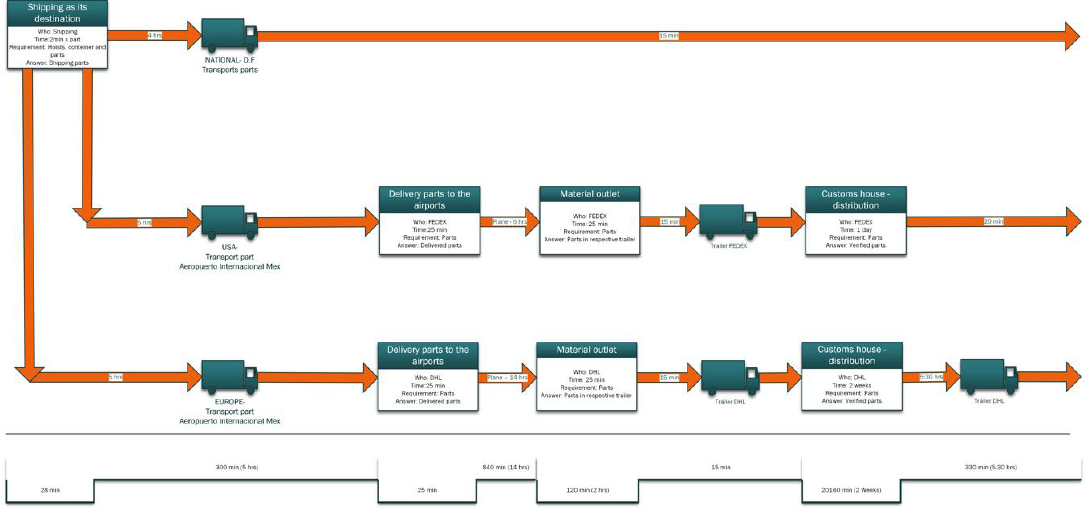
Figure 6. The fourth part of seven of the Current VSM is displayed.